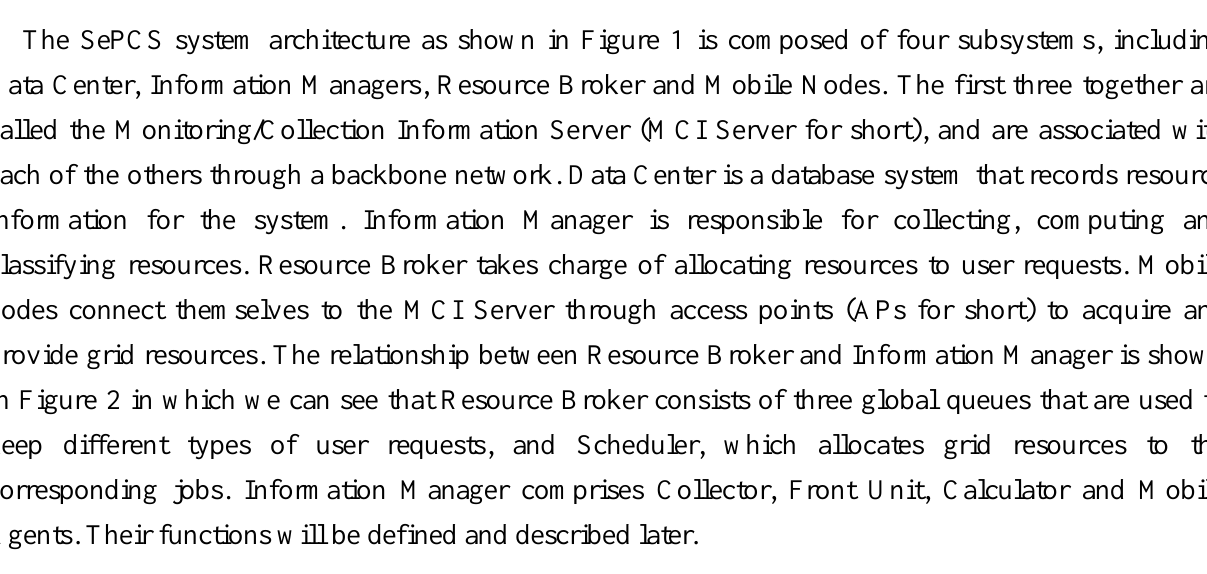
Figure 1. The SePCS system